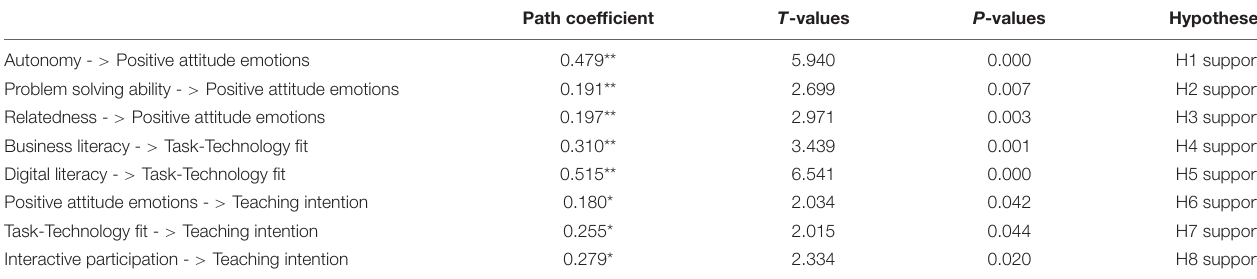
TABLE 5 | Estimation results for